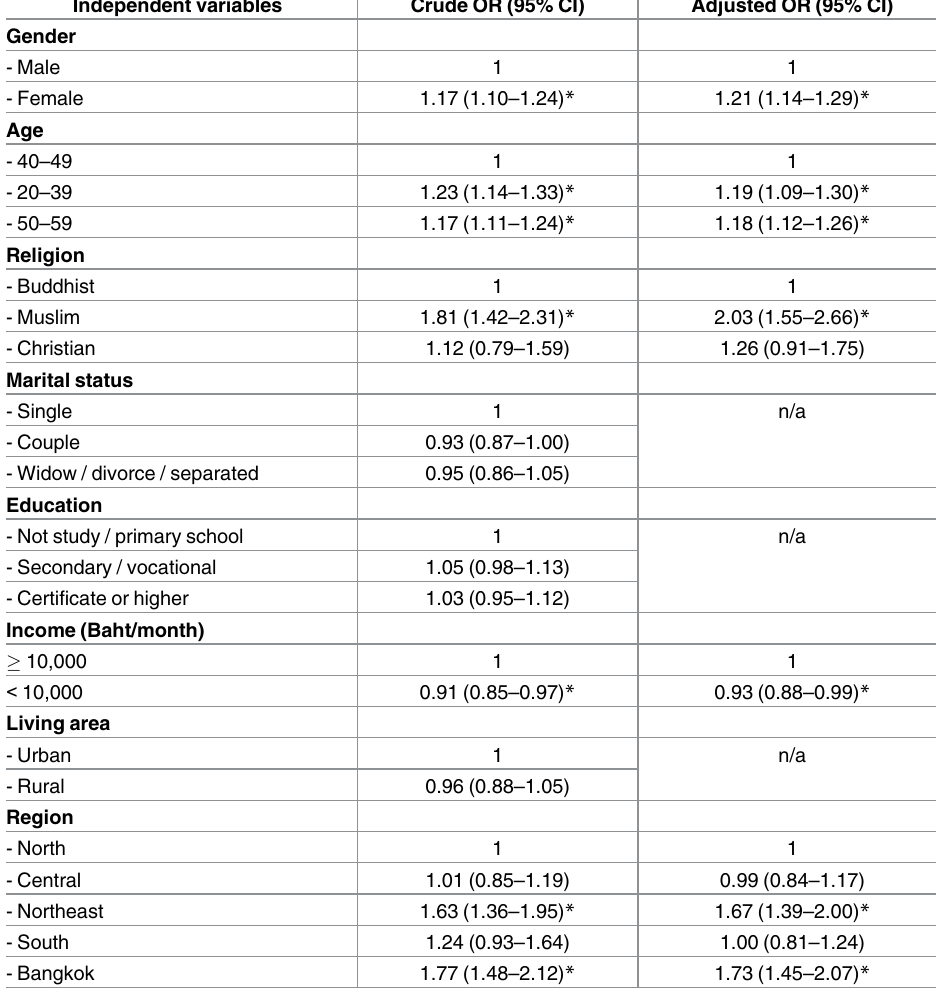
Table 5. Bivariate and multivariate analysis of factors associated with the UNAIDS’s global indicator on discriminatory attitude toward PLHIV. Independent